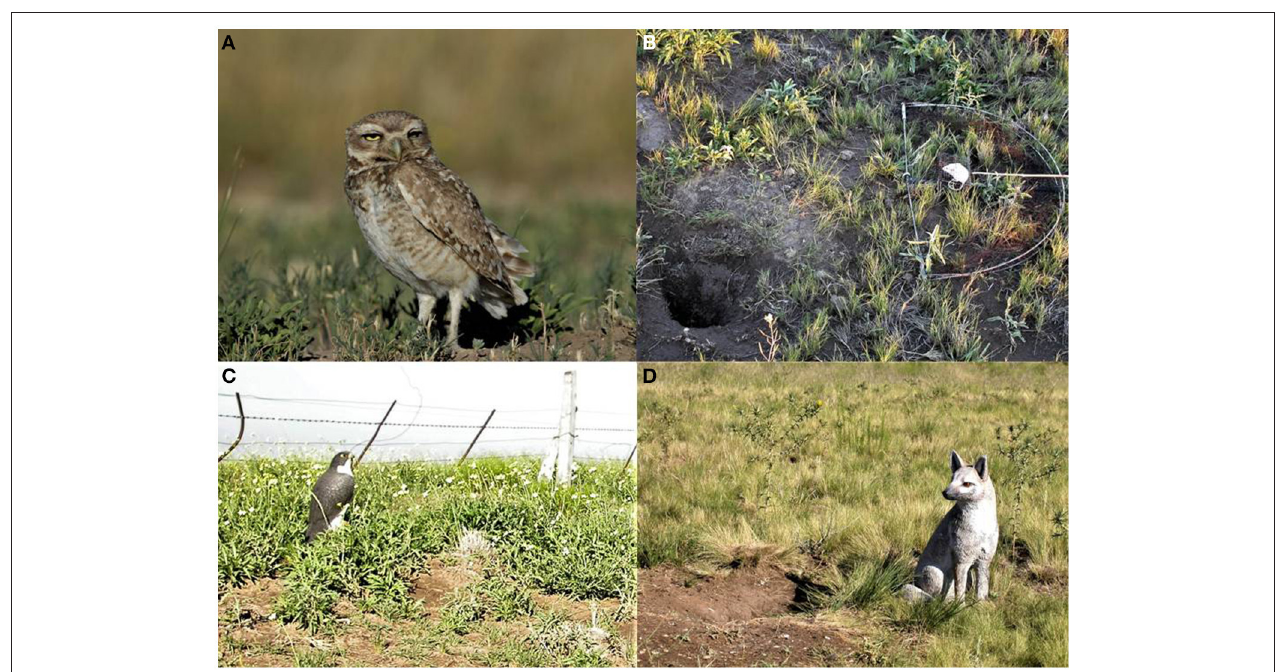
FIGURE 1 | Breeding burrowing owls were systematically approached by a researcher to measure their flight initiation distances when they were perching close to their nests (A) , and then were sequentially exposed to a trap with a white laboratory mouse kept within a small cage (B) , and polyester reproductions of a Peregrine Falcon Falco peregrinus (C) and a Pampa Fox Pseudalopex gymnocercus (D) placed close to the entrance of their nests.